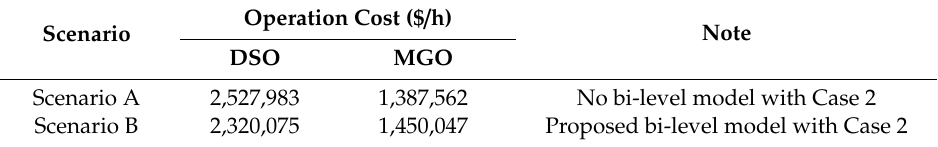
Table 8. Comparison of operational costs for each Scenario in Case 2.